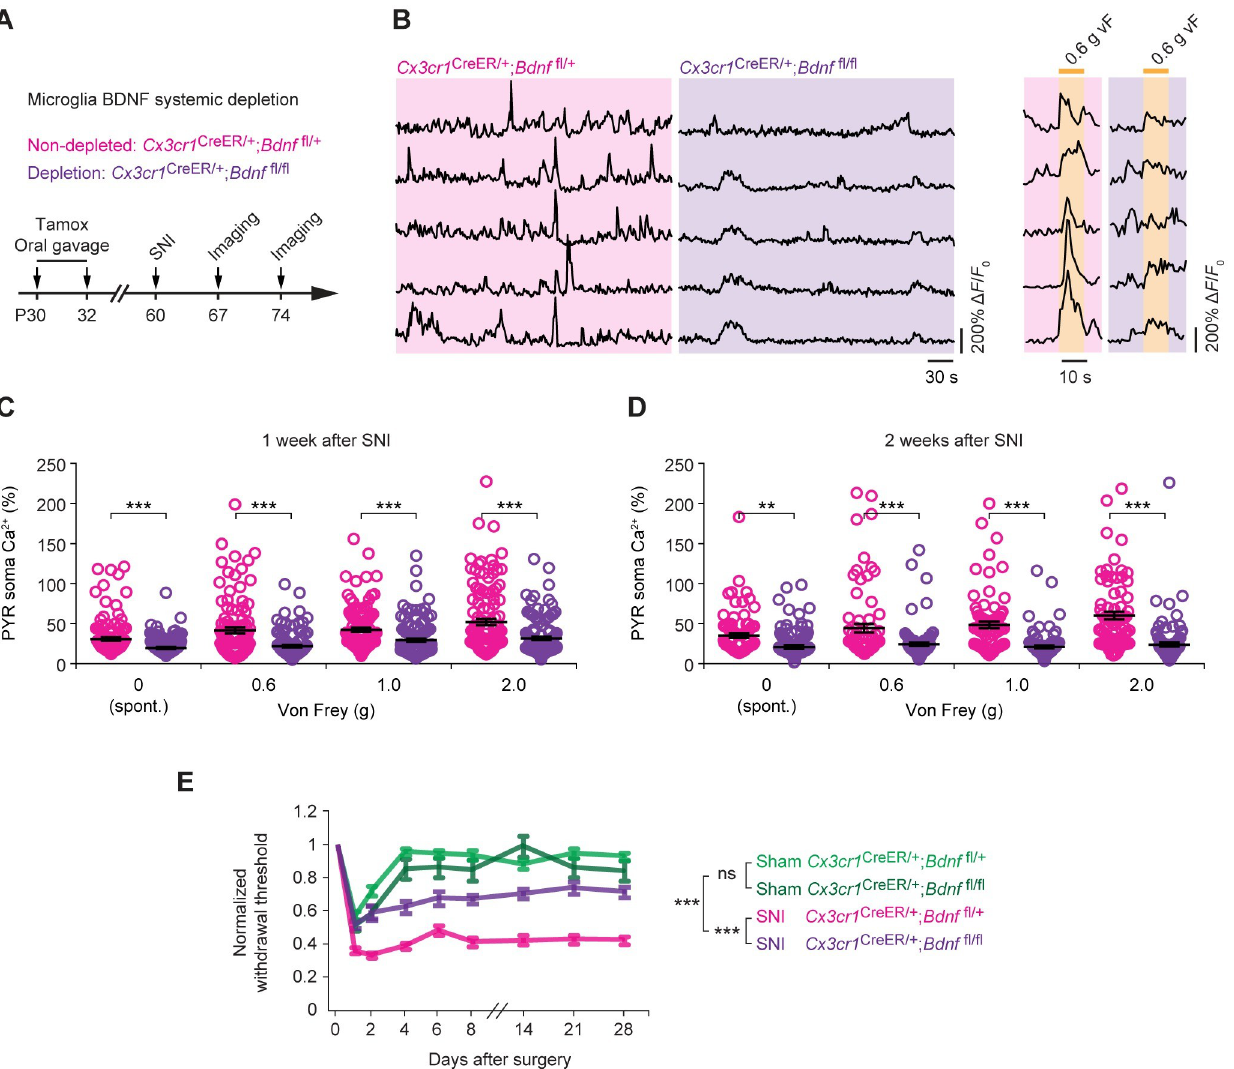
Fig 6. Systemic depletion of microglial BDNF reduces pyramidal neuronal hyperactivity and mechanical allodynia. ( A ) Experimental timeline. ( B ) Representative fluorescence traces of L5 PYR somas expressing GCaMP6s in SNI mice with ( Cx3cr1 CreER/+ ; Bdnf fl/+ ) or without ( Cx3cr1 CreER/+ ; Bdnf fl/fl ) microglial BDNF. Images were collected 1 week after surgery when mice were at rest or subjected to 0.6-g vF stimulation. ( C ) Averaged Ca 2+ activity in L5 somas 1 week after SNI ( Bdnf fl/+ , n = 4 mice; Bdnf fl/fl , n = 5 mice; 0 g: t 246 = 3.551, P < 0.001; 0.6 g: t 220 = 5.143, P < 0.001; 1.0 g: t 232 = 3.986, P < 0.001; 2.0 g: t 244 = 4.751, P < 0.001). ( D ) Averaged Ca 2+ activity in L5 somas 2 weeks after SNI ( Bdnf fl/+ , n = 5 mice; Bdnf fl/fl , n = 4 mice; 0 g: t 171 = 2.666, P = 0.0084; 0.6 g: t 177 = 3.913, P < 0.001; 1.0 g: t 179 = 6.709, P < 0.001; 2.0 g: t 174 = 6.918, P < 0.001). ( E ) Paw withdraw threshold in sham and SNI mice with or without microglial BDNF (sham Bdnf fl/+ , n = 7 mice; SNI Bdnf fl/+ , n = 9 mice; sham Bdnf fl/fl , n = 9 mice, SNI Bdnf fl/fl , n = 8 mice). ( B ) Representative traces from experiments carried out on at least 4 animals per group. Throughout, individual circle represents data from a single cell. Summary data are presented as means ± SEM. �� P < 0.01, ��� P < 0.001; by unpaired t test ( C , D ) or two-way ANOVA followed by Bonferroni multiple comparisons test ( E ). The data underlying this figure can be found in S1 Data. BDNF, brain-derived neurotrophic factor; L5, layer 5; ns, not significant; PYR, pyramidal; SNI, spared sciatic nerve injury; vF, von Frey.